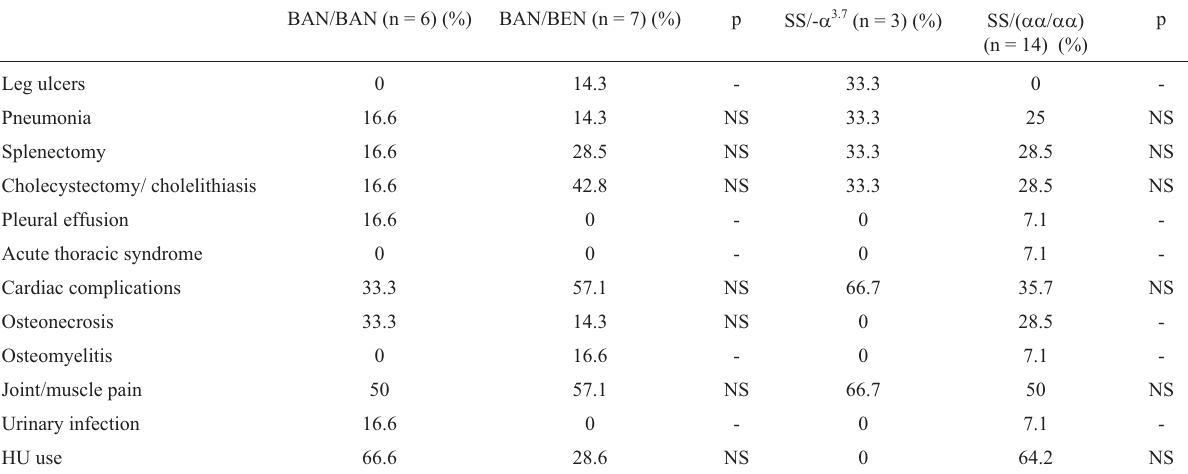
Table 6 - Hydroxyurea (HU) use and frequency of clinical manifestations in SCA patients according to (cid:2) S gene haplotype, - (cid:3) 3.7kb thalassemia coinheri- tance and normal (cid:3)